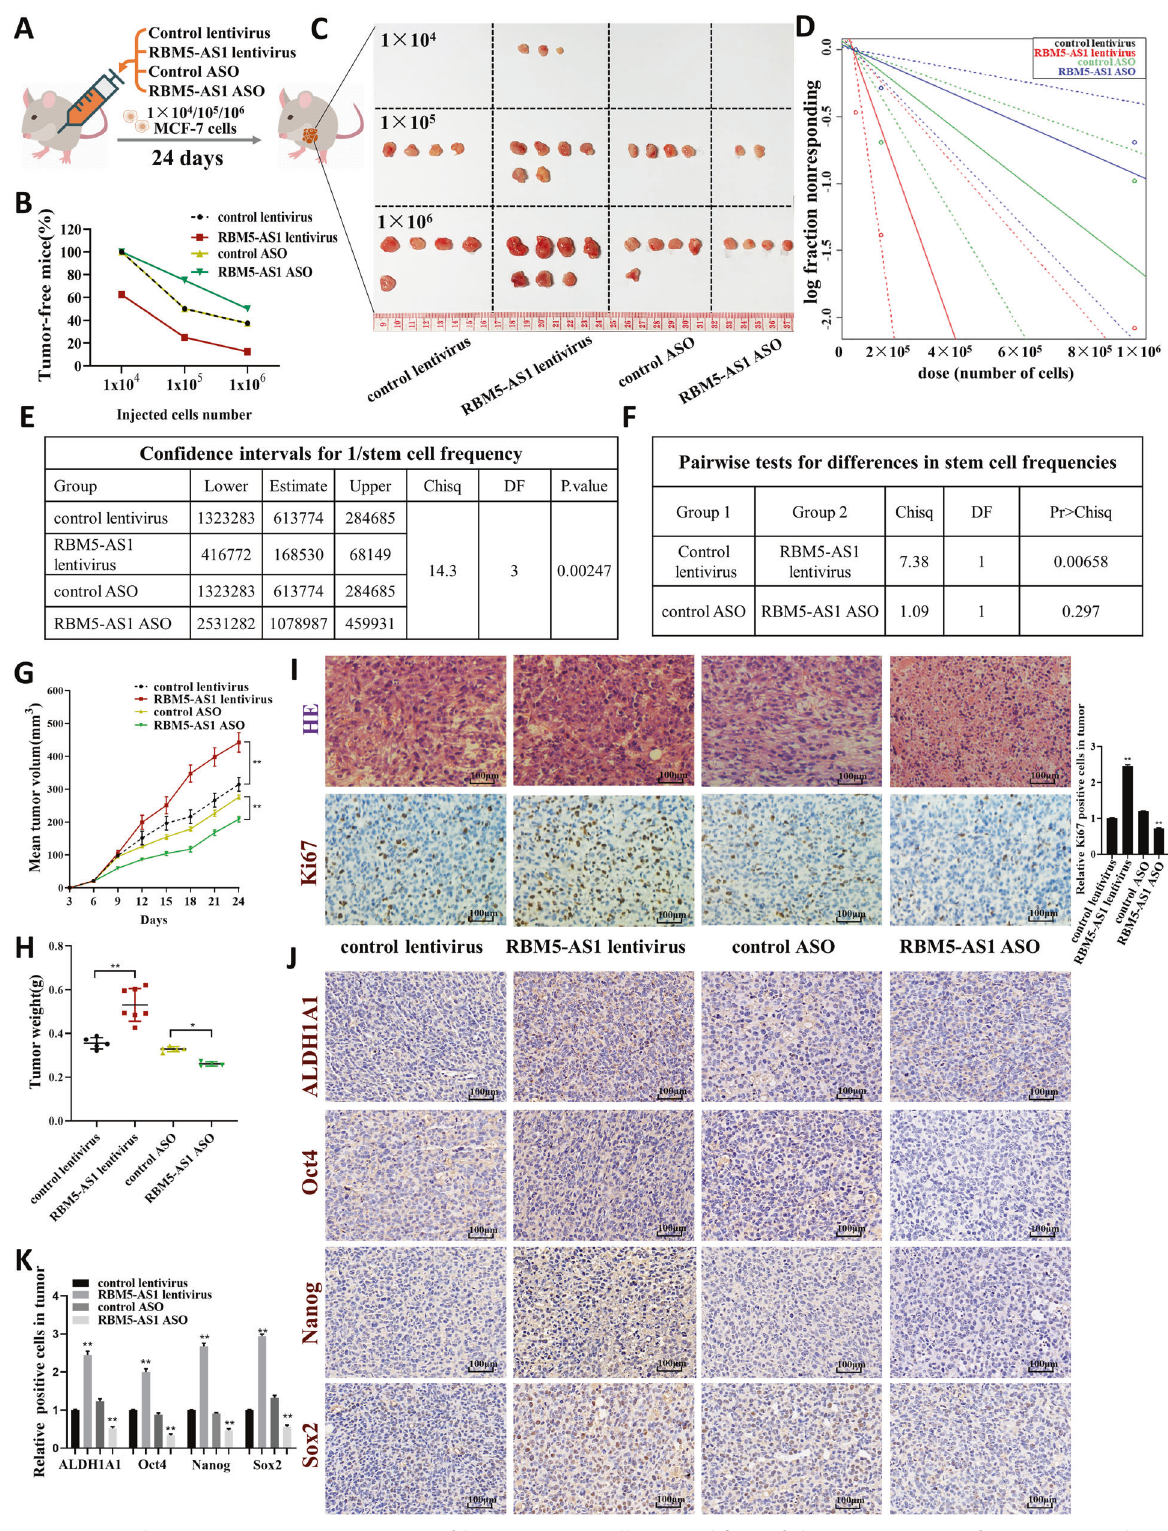
Fig. 4 RBM5-AS1 enhances in vivo tumorigenicity of breast cancer cells. A Work fl ow of the in vivo xenograft experiments designed for examining tumor proliferative capacity and stemness. B In vivo limiting dilution tumorigenicity studies of indicated MCF-7 cells were used to determine the ef fi cacy of RBM5-AS1 on the tumor-initiating frequency. The xenografts were dissected and measured after 24 days; n = 8 for each group. Images ( C ) and index ( D – F ) of tumors harvested after different MCF-7 cells serially diluted were planted for 24 days. Tumor volume ( G ) and weight ( H ) of the tumors from mice subcutaneously implanted with 1 × 10 6 cells were measured. Representative images of HE staining and Ki-67 IHC staining ( I ), ALDH1A1, Oct4, Nanog, and Sox2 IHC staining ( J ) of the tumor sections. Scale bar, 100 μ m. IHC staining of ALDH1A1, Oct4, Nanog, and Sox2 were performed three times independently ( K ). All data are shown as the mean ± SEM. * P < 0.05 and ** P < 0.01 by two-tailed Student ’ s t -test. Cell Death and Disease (2022)